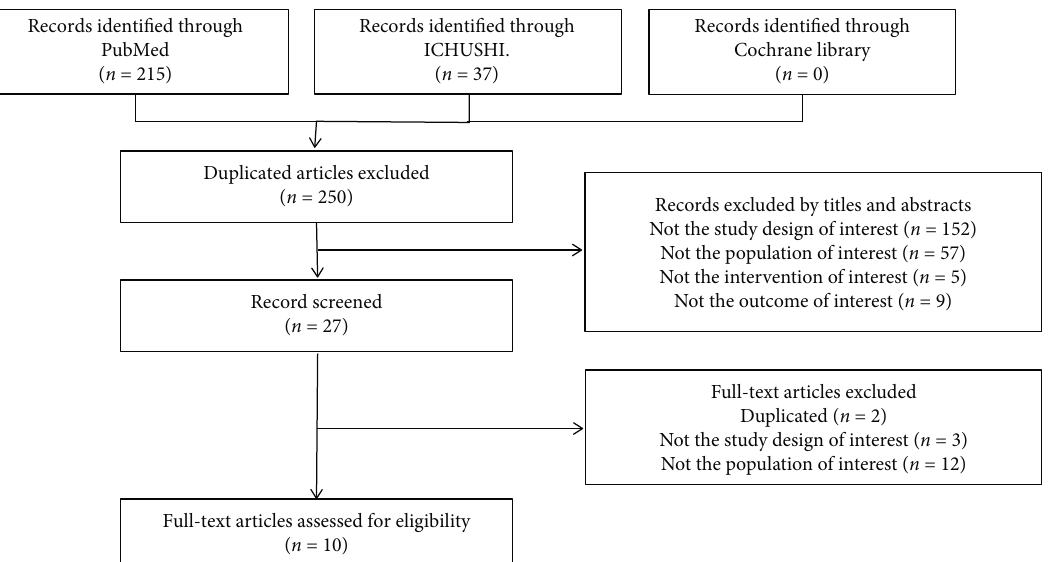
Figure 1: The fl ow diagram of the literature selection